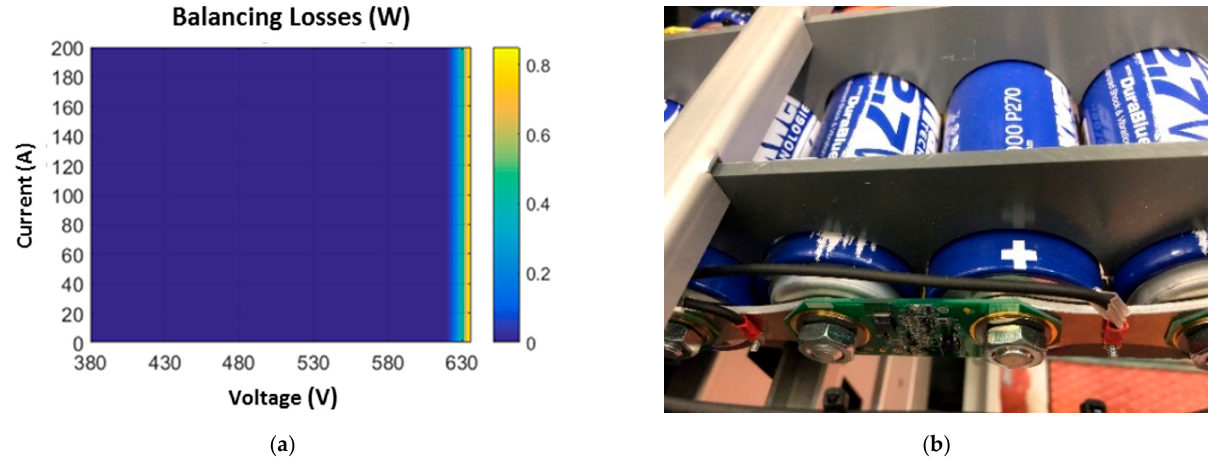
Figure 5. ( a ) Power loss map in the voltage balancing system as a function of current and voltage and ( b ) detail of the connection plates between the cells and of the voltage balancing system.